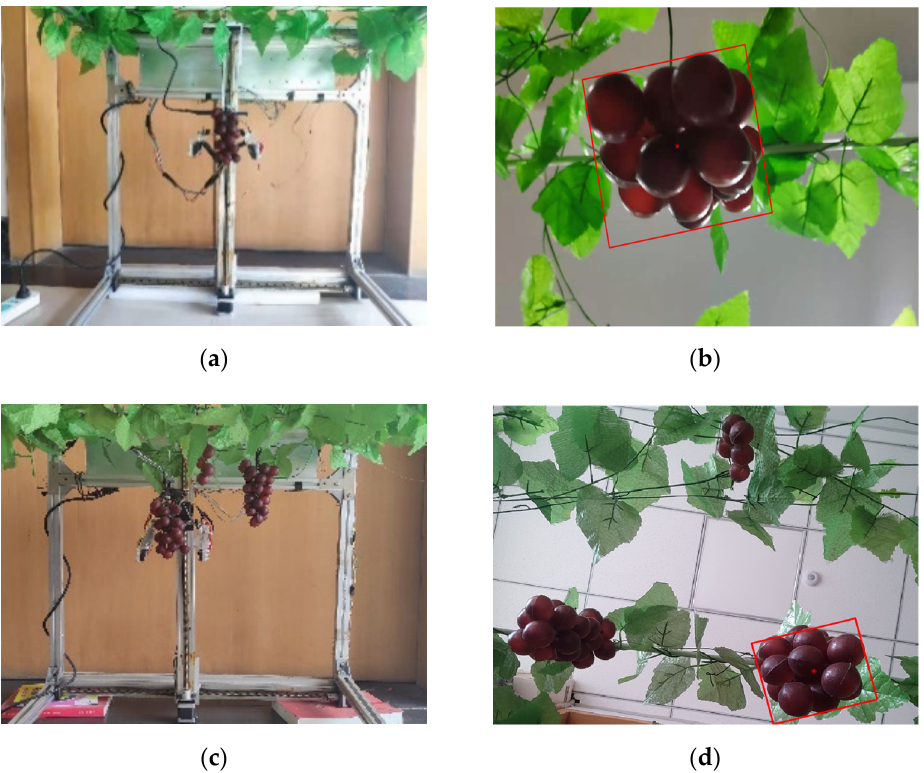
Figure 10. The test platform of the visual system. ( a ) Front view. ( b ) Identification results 1. ( c ) Front view. ( d ) Identification results 2.